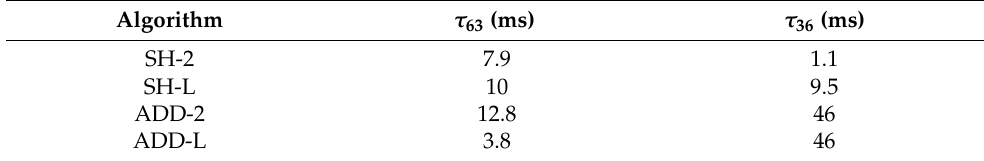
Table 3. Ideal response times for selected algorithm.